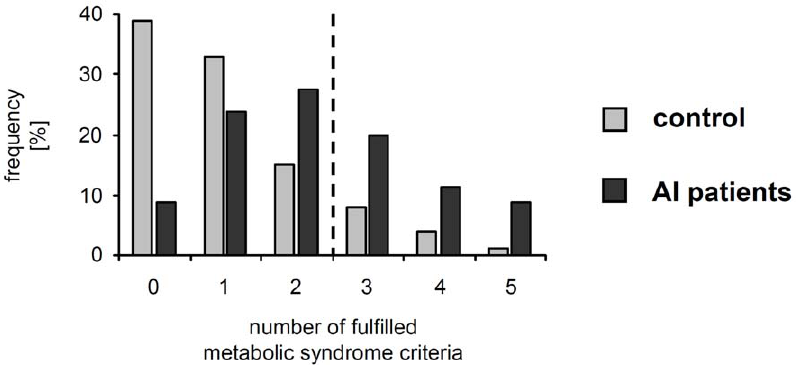
Figure 2. Percentages of AI patients and control participants that fulfilled the indicated number of metabolic syndrome criteria. The dashed vertical line marks the cutoff for the metabolic syndrome.